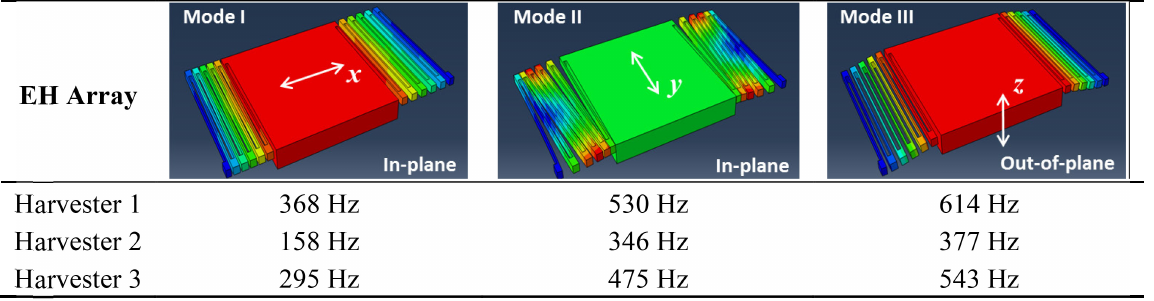
Table 1. Simulated vibration modes summary of the energy harvester (EH) array